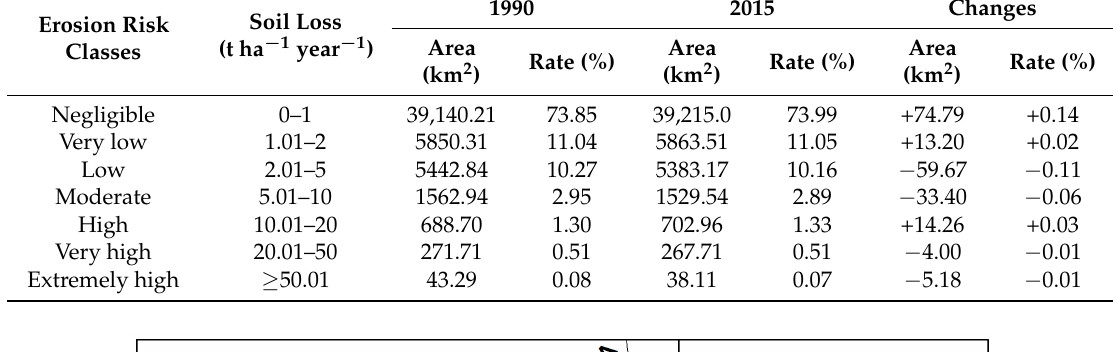
Table 4. Spatial distribution of soil loss, erosion risk classes and the erosion rates in 1990 and 2015.